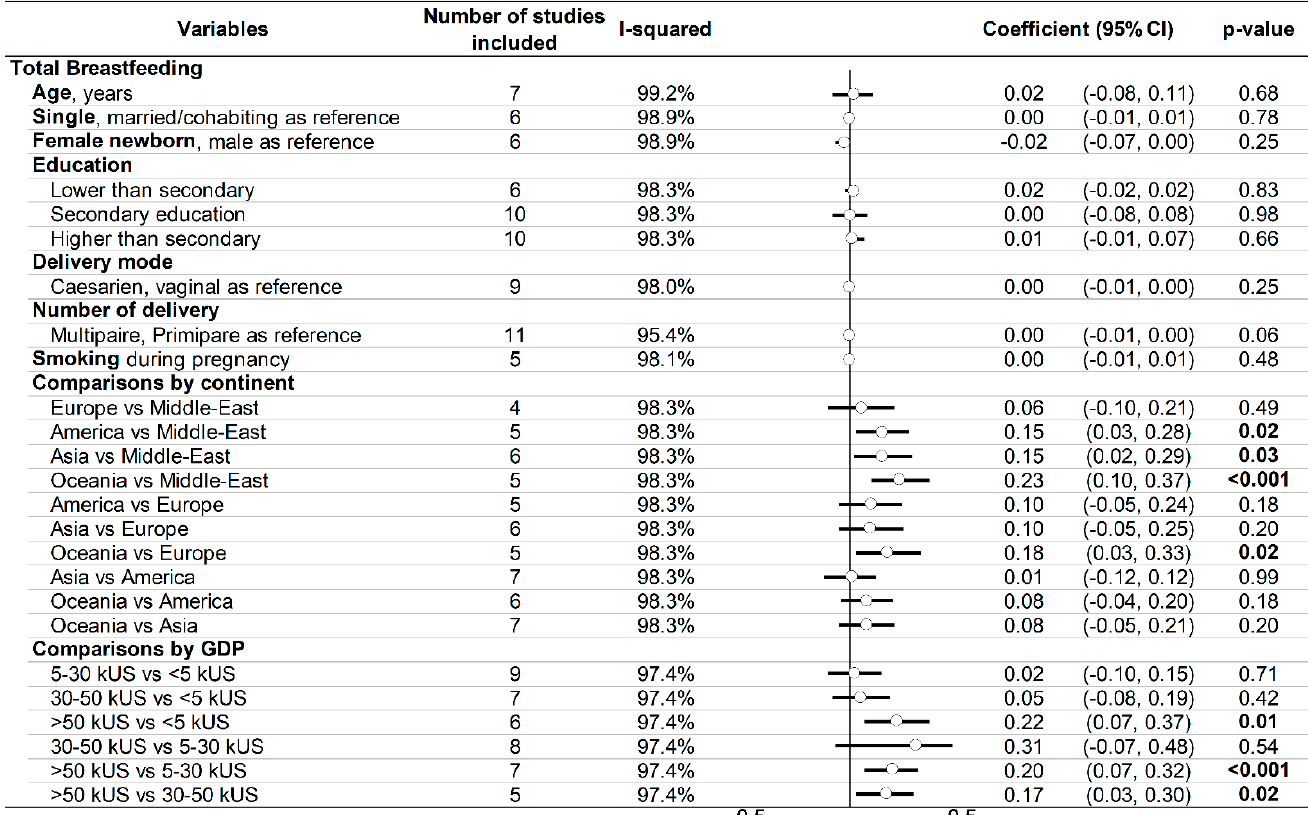
Figure 3. Meta-funnels.